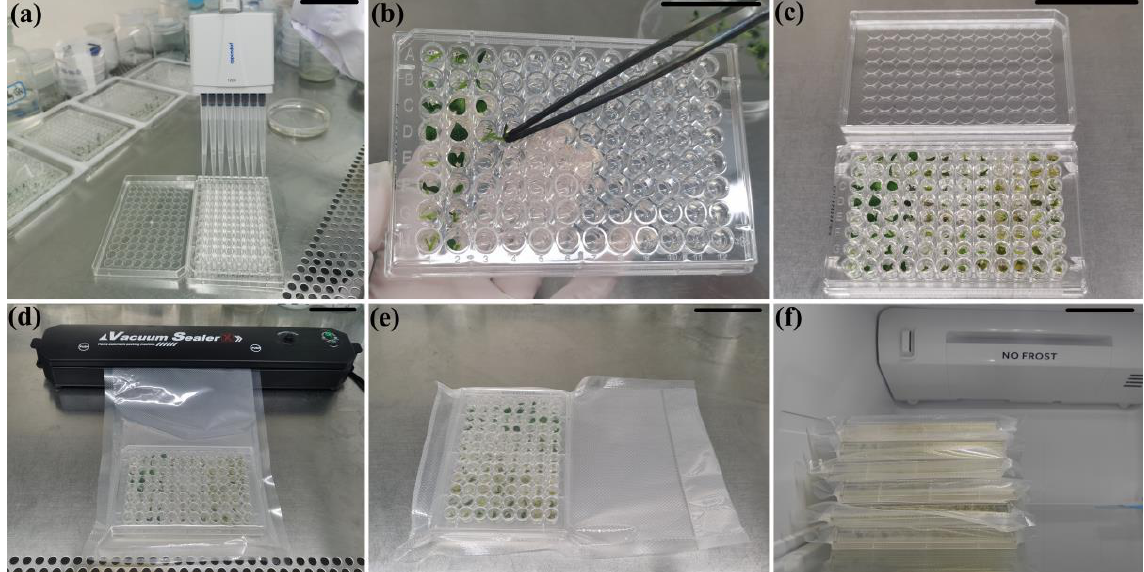
Figure 2. Manufacturing procedures of microplate shipping of vacuum-packed plant micro-cuttings. ( a ) Loading each of microplate well with 200 uL 1/4MS 100 CCC medium; ( b ) micro-cutting culture; ( c ) cutting cultured plate; ( d ) vacuumization; ( e ) vacuum-packed plate; ( f ) packaged plates stored at 10 °C in the dark (light on state in picture). Bar indicates 5 cm.